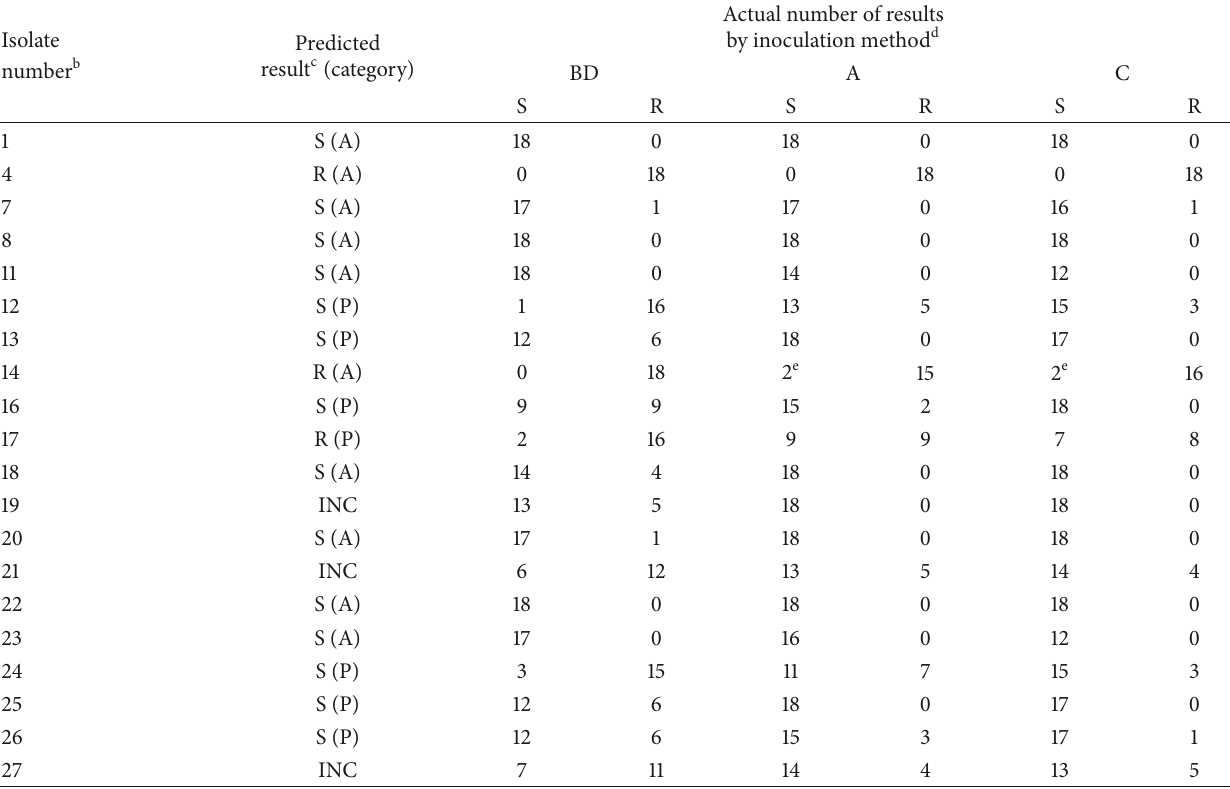
Table 4: Comparison of predicted to actual MGIT PZA susceptibility test results stratified by inoculation method. Cumulative results of 9 laboratories a each testing 20 isolates in